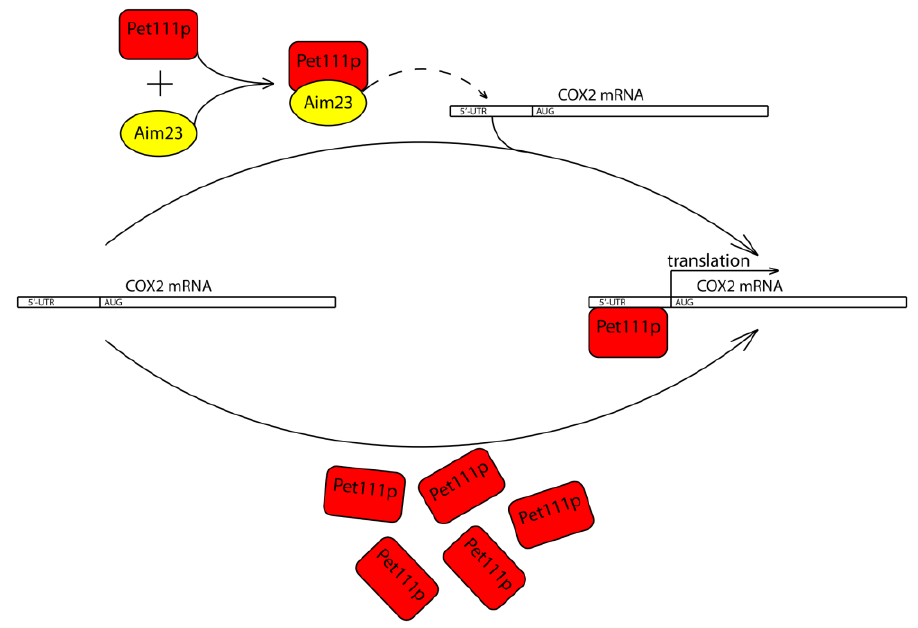
Figure 4. Working model of Aim23p involvement in the COX2 mRNA translation. Aim23p does not seem to directly contact UTRs of this mRNA, or at least this potential contact plays secondary role in the whole process. Instead, Aim23p interacts with Pet111p. This interaction facilitates Pet111p binding to the 5′-UTR of the COX2 mRNA, which, in turn, ensures its proper translation. In case when the amount of Pet111p is increased, no Aim23p is needed for activator interaction with COX2 mRNA.